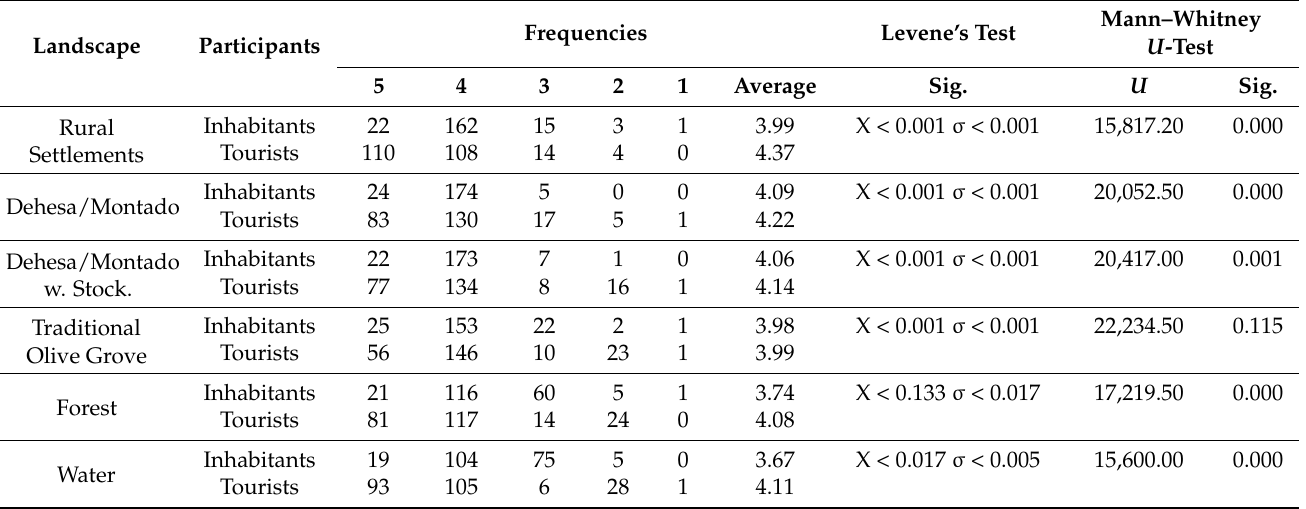
Table 3. Results obtained through the Mann–Whitney U test and Levene’s test comparing the evaluations of the landscapes between inhabitants and